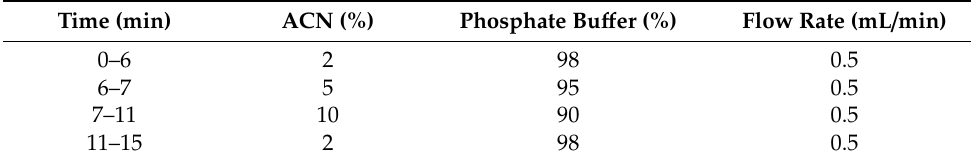
Table 7. Gradient conditions for the elution of THCl and NA in PBS.